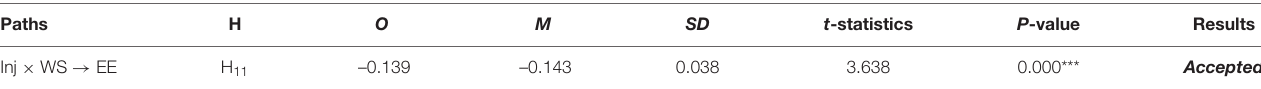
FIGURE 4 | Structural model with moderation. TABLE 10 | Moderating effects of the